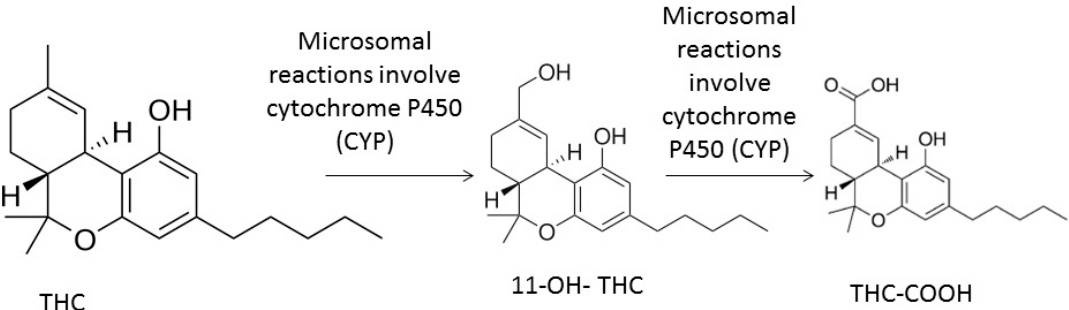
Figure 2. Main metabolites of THC.